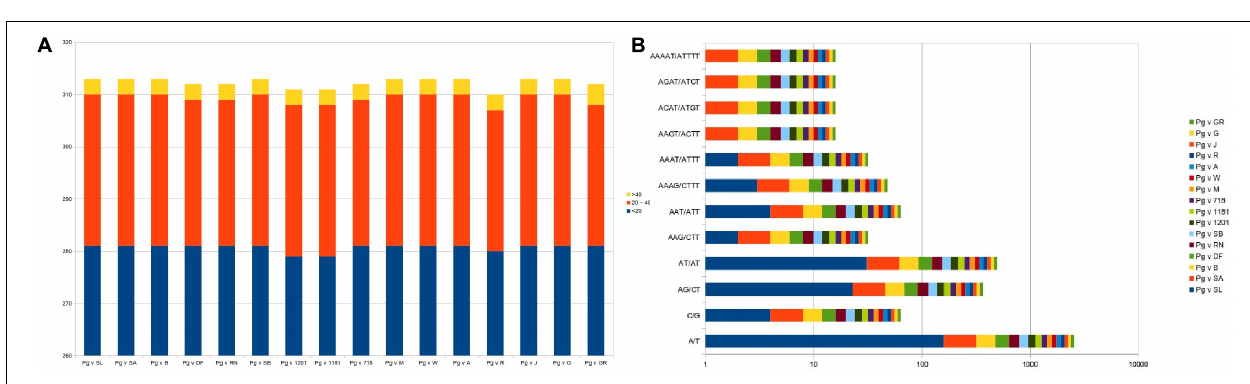
FIGURE 5 | Repeat analysis and frequency distribution for (A) tandem repeats and (B) SSR motif types across the 16 plastid